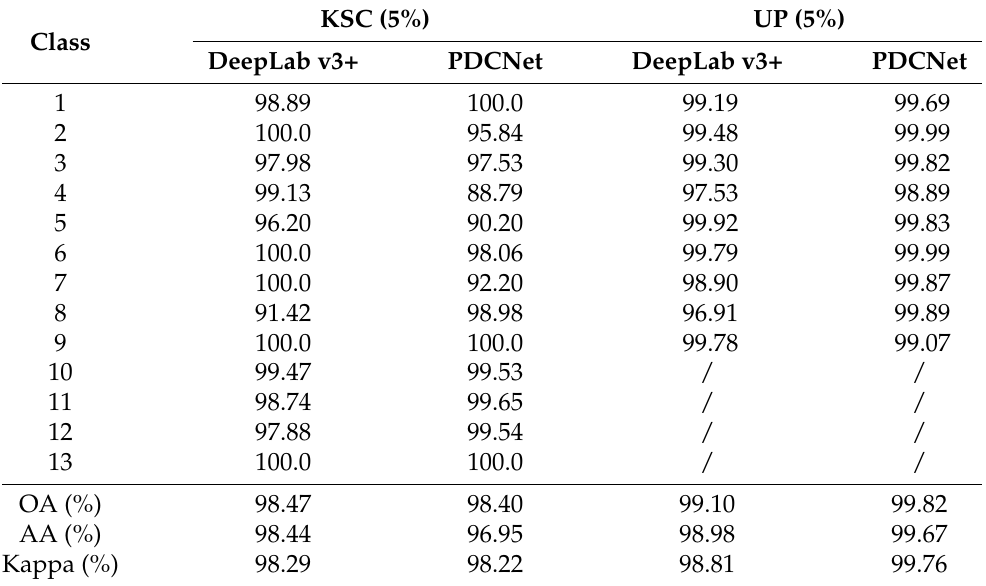
Table 11. The classification results of PDCNet and DeepLab v3+ on the KSC and UP datasets based on 5% of the training